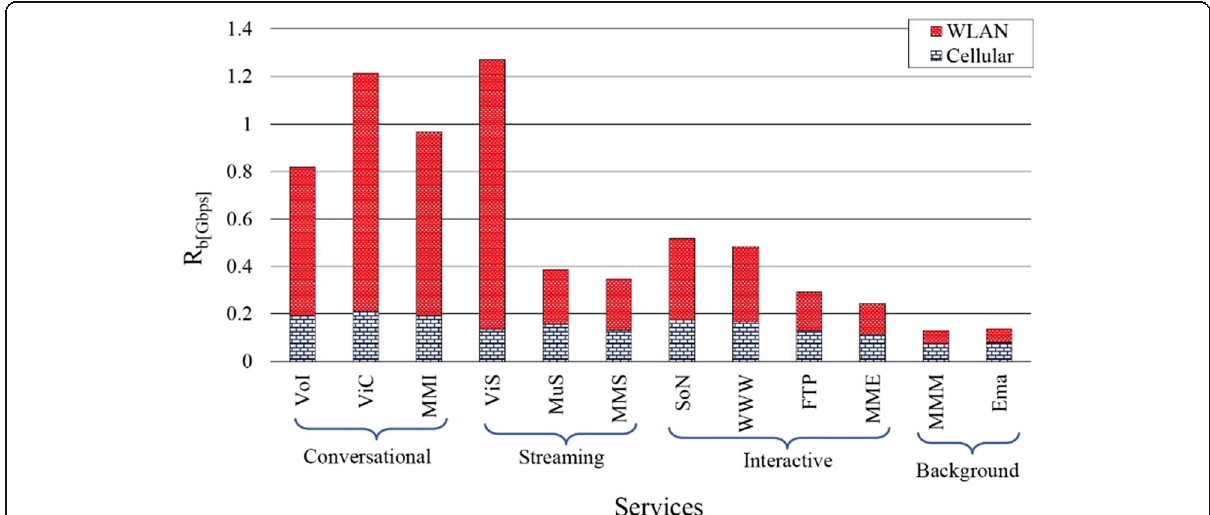
Fig. 4 Data rate allocated to different services from WLAN and cellular